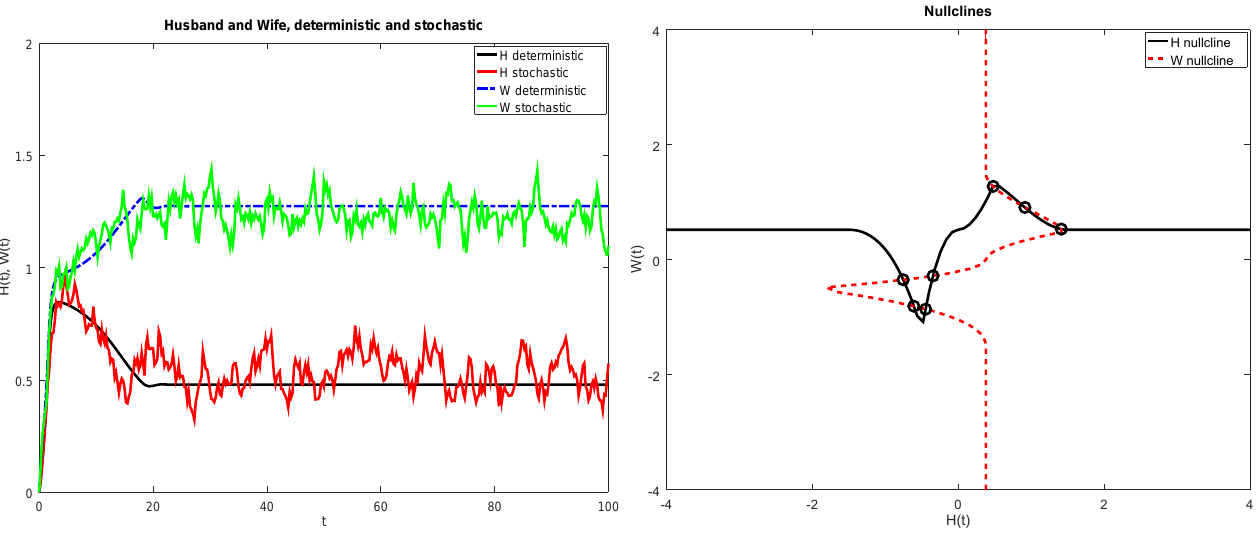
Figure 8. Piecewise linear influence functions. Plot of H and W vs. time for the deterministic case and a stochastic realization with initial values H 0 = − 0.47, W 0 = − 1.14.